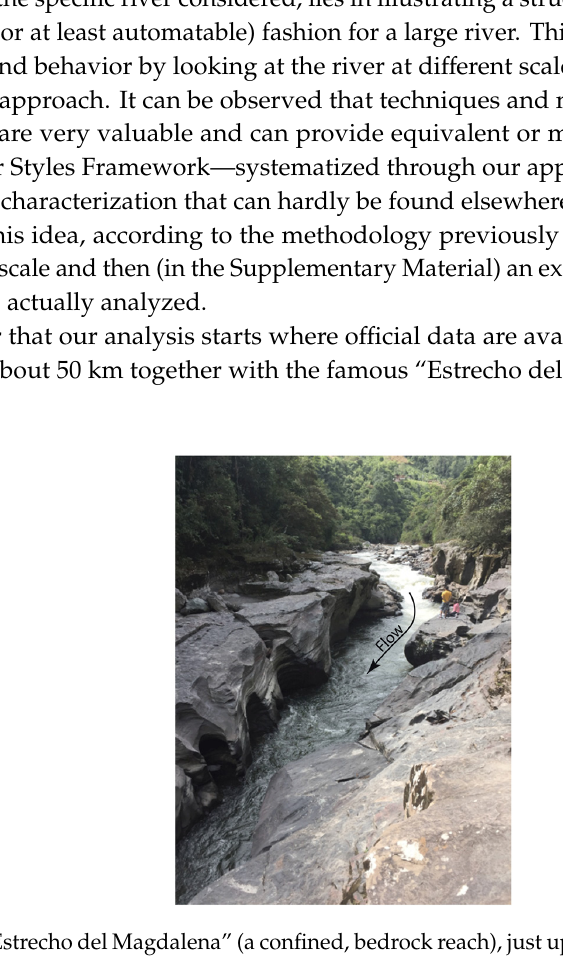
Figure 4. The “Estrecho del Magdalena” (a confined, bedrock reach), just upstream of our starting point.